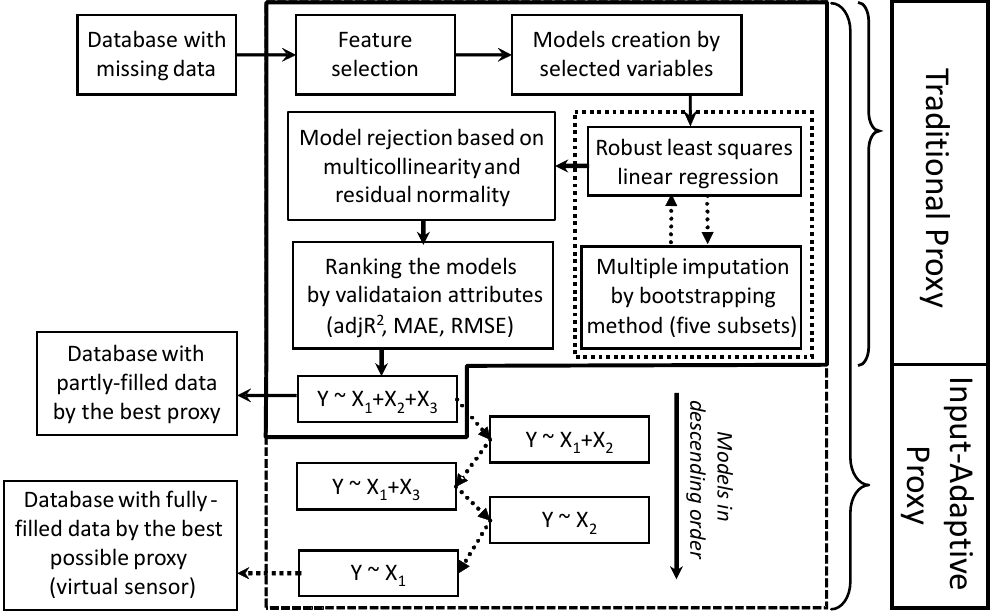
Figure 1. Schematic diagram of the procedures of developing the recursive input-adaptive proxy.